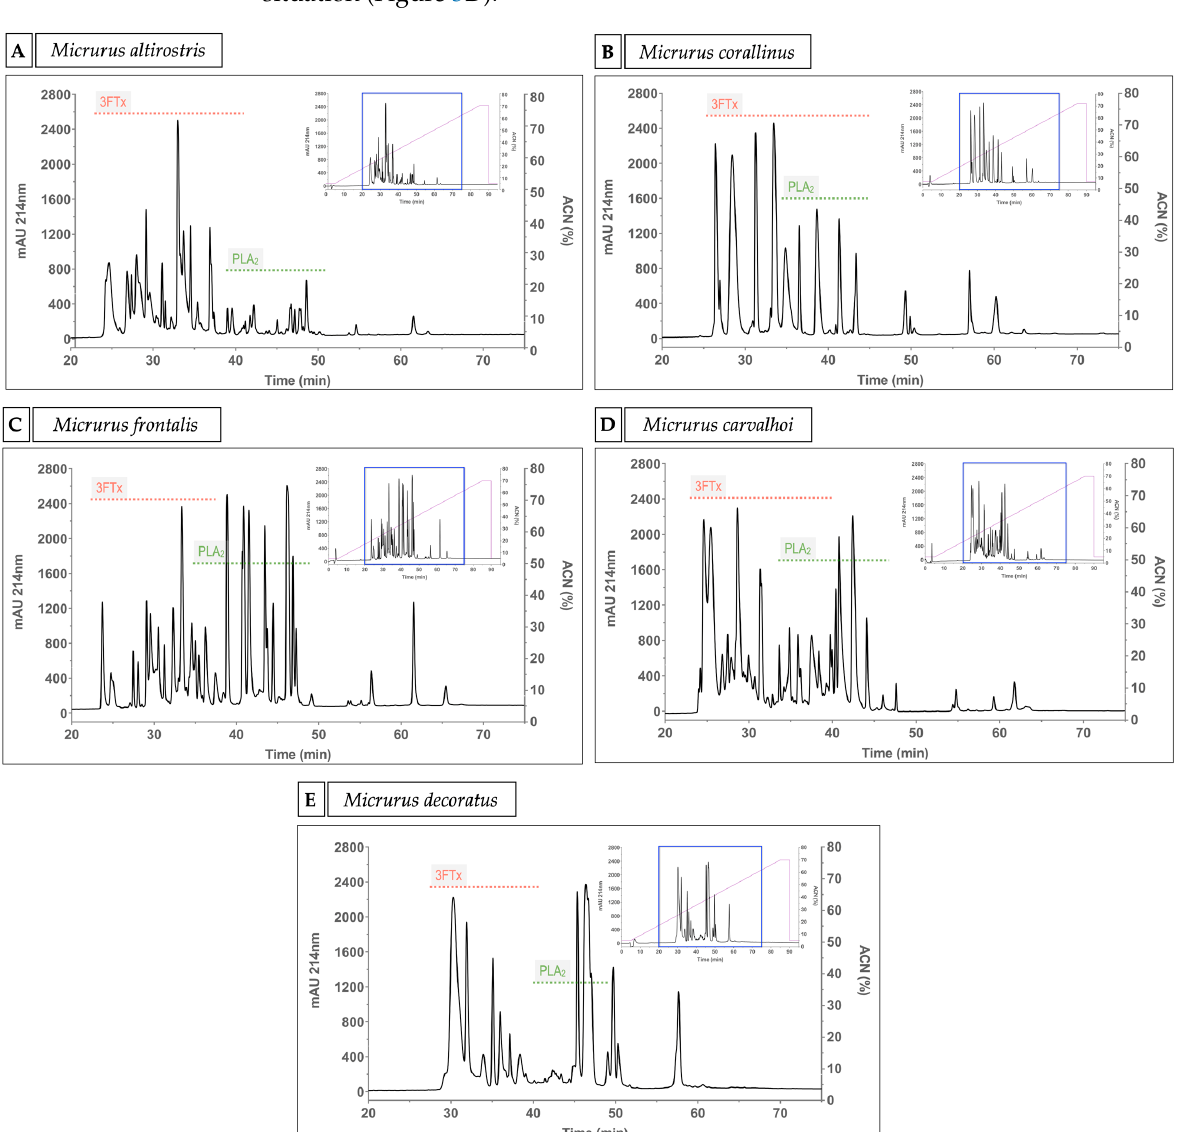
Figure 2 . Crude venom chromatographic profiles. ( A ) Micrurus altirostris , ( B ) Micrurus corallinus , ( C ) Micrurus frontalis , ( D ) Micrurus carvalhoi and ( E ) Micrurus decoratus venoms. A total of 500 µg of crude venom was used to obtain the RP-HPLC profile. Based on the published proteome information of Micrurus species venoms [8–10], we show in the figure the approximate elution regions of 3FTxs and PLA 2 s, marked by dotted lines in red and green, respectively. The right superior panel in each figure shows the full area of the chromatogram, where the blue box represents the zoomed area and the purple line represents the acetonitrile (ACN)